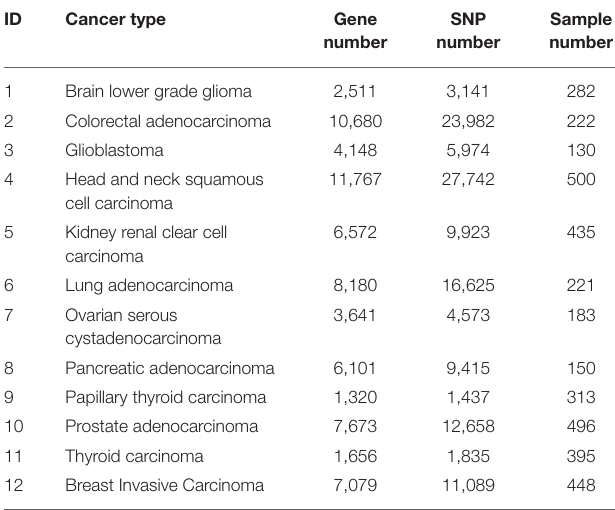
TABLE 1 | Cancer data used for training and validating biomarkers.